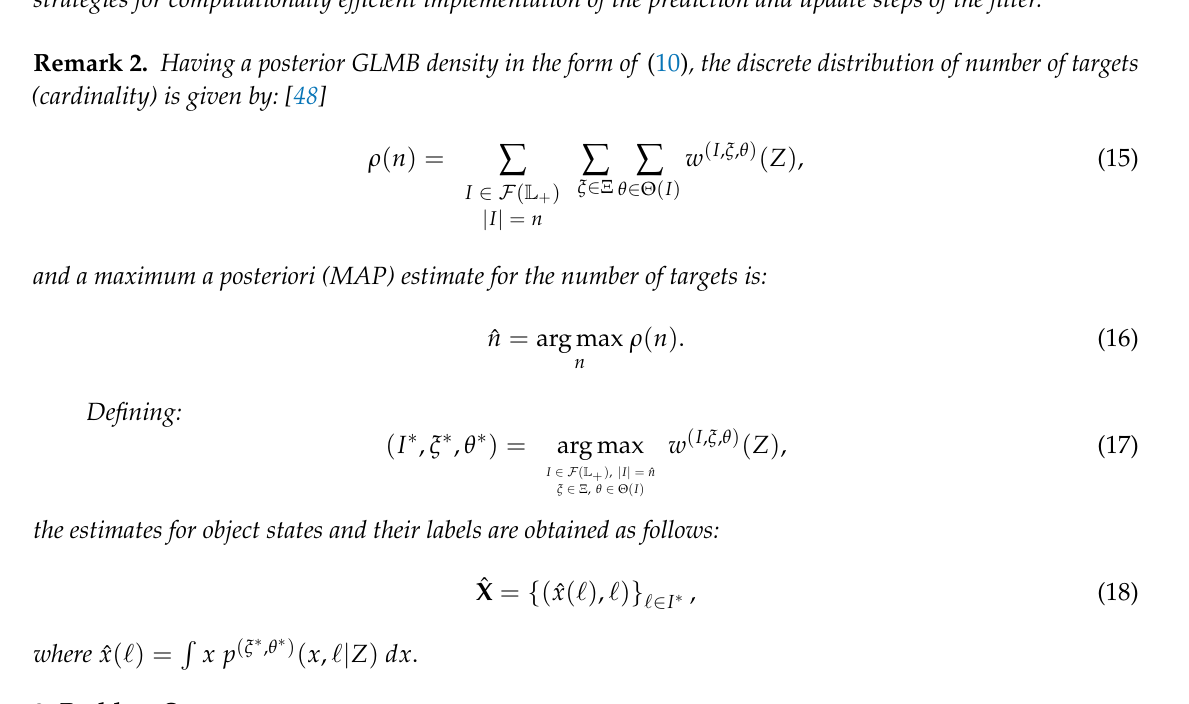
Figure 1. Person with initial label ( (cid:96) from time k + 1 to time k + 4, and re-tracked with label ( (cid:96)